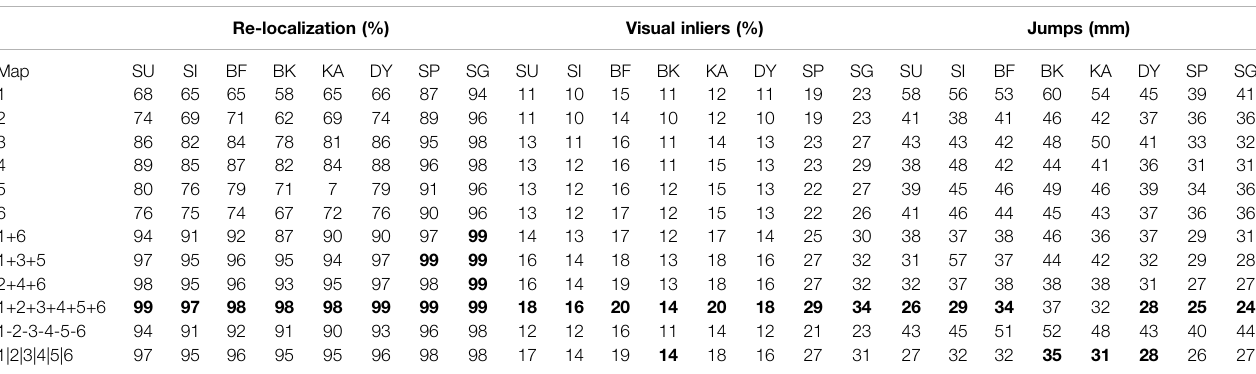
TABLE 2 | Cumulative re-localization performance (%) and average re-localization jumps (mm) of the six localization sessions on each map for each visual feature used. Re-localization (%) Visual inliers (%) Jumps